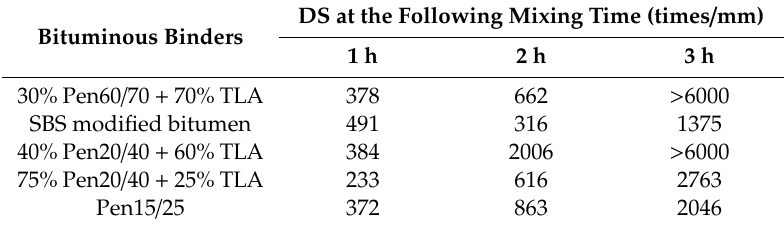
Table 5. E ff ect of bituminous binder and mixing time on DS. Bituminous